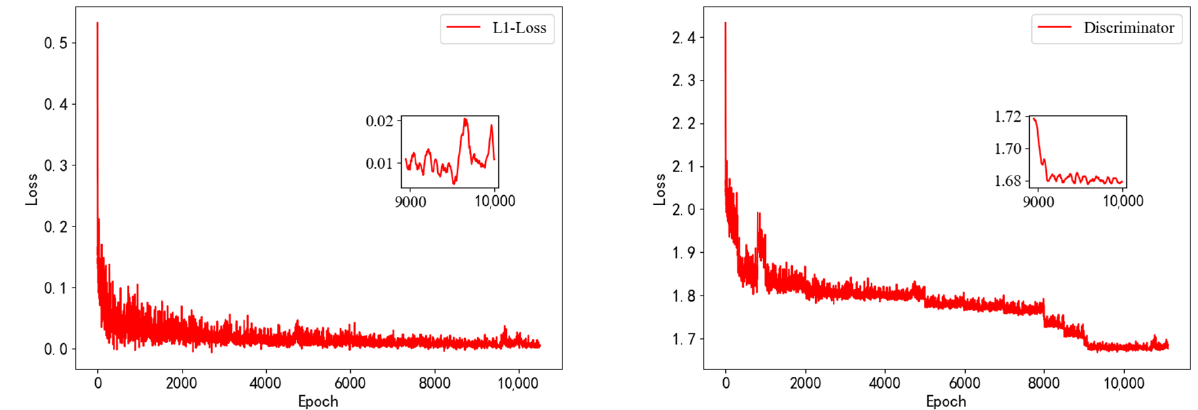
Figure 9. Loss function curves for the generator loss L L 1 ( G ) and discriminator loss G ∗ .